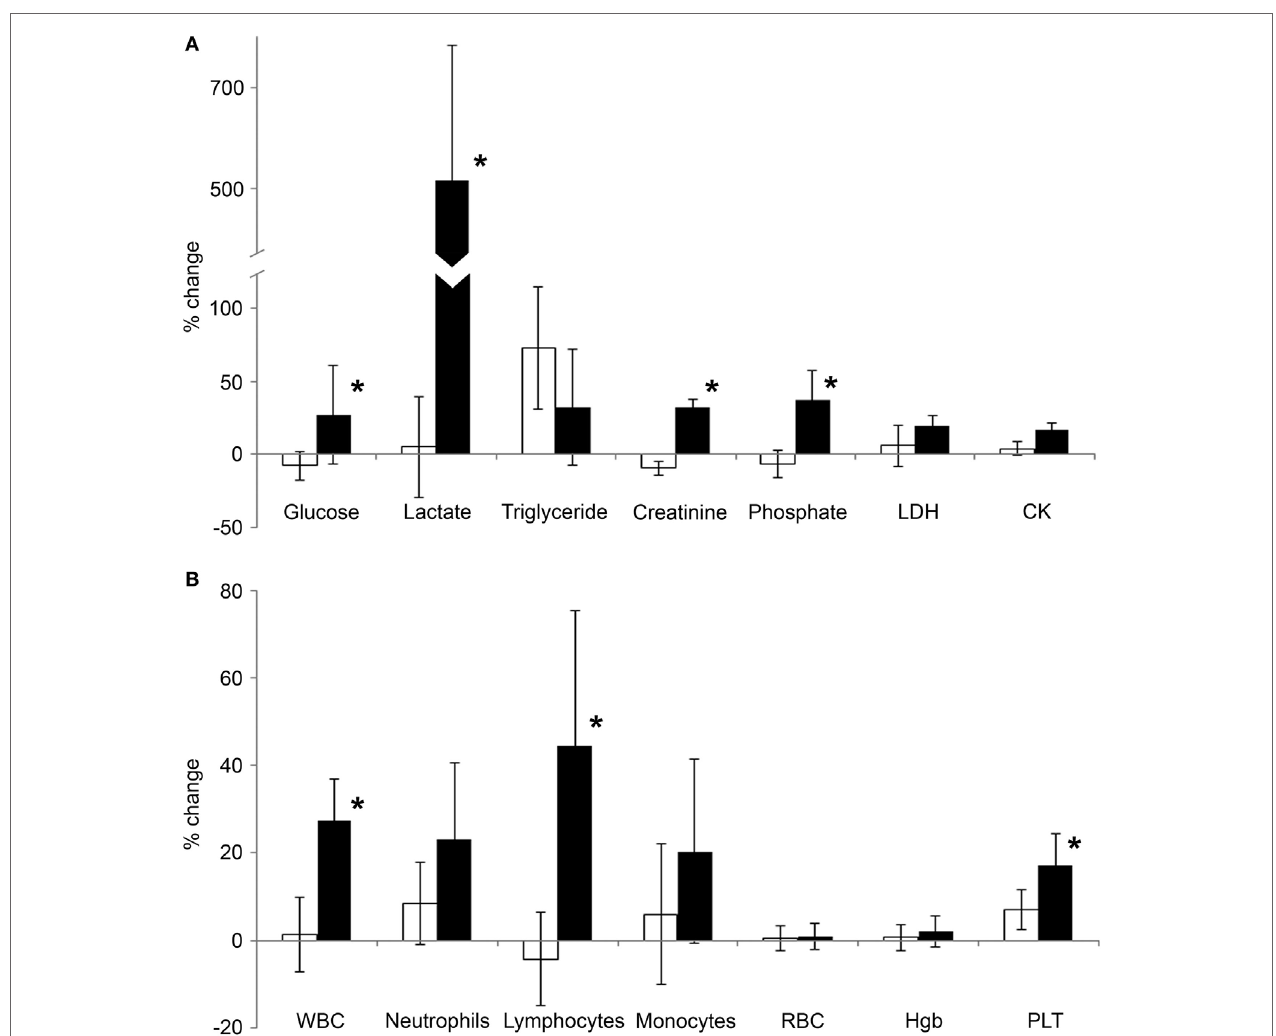
FigUre 1 | Average change of serum biochemical and blood cell parameters following exercise. Blood was collected from volunteers in the morning, 3 h prior to the exercise, and then a second blood sample was collected from the same individuals after a 2-mile running exercise. Previously, the same experimental protocol was also carried out with the same individuals when they were asked to rest instead of running. (a) Average intra-daily changes of various serum biochemical parameters related to metabolism (glucose, lactate, triglyceride, creatinine, and phosphate) or tissue damage [lactate dehydrogenase (LDH), CK] were calculated after exercise (black bars) or after resting (open bars). (B) Average intra-daily changes of the key blood cell parameters were calculated in samples collected after exercise (black bars) or after resting (open bars). Relative changes after exercise or resting were expressed as percentages of the corresponding, “before” values. Data are mean ± SD, * p < 0.05 vs the change of the resting